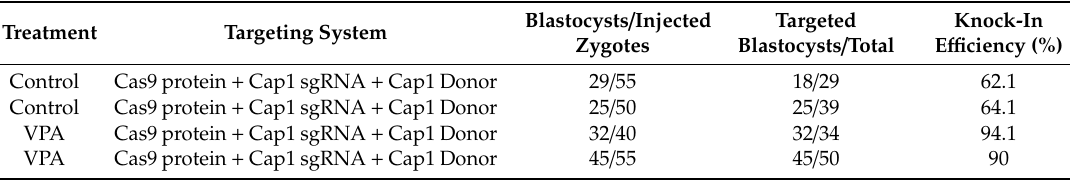
Table 2. CRISPR / Cas9-mediated knock-in e ffi ciencies in mouse embryos. Cas9 protein, Cap1 sgRNA, and the linearized Cap1 donor vector were injected into the cytoplasm of the mouse embryos. The zygotes were cultured with or without VPA in M2 media 1 h before the microinjection and cultured in KSOM medium, with or without VPA until the blastocysts stage (3.5 days of culture) and analyzed by PCR and Sanger